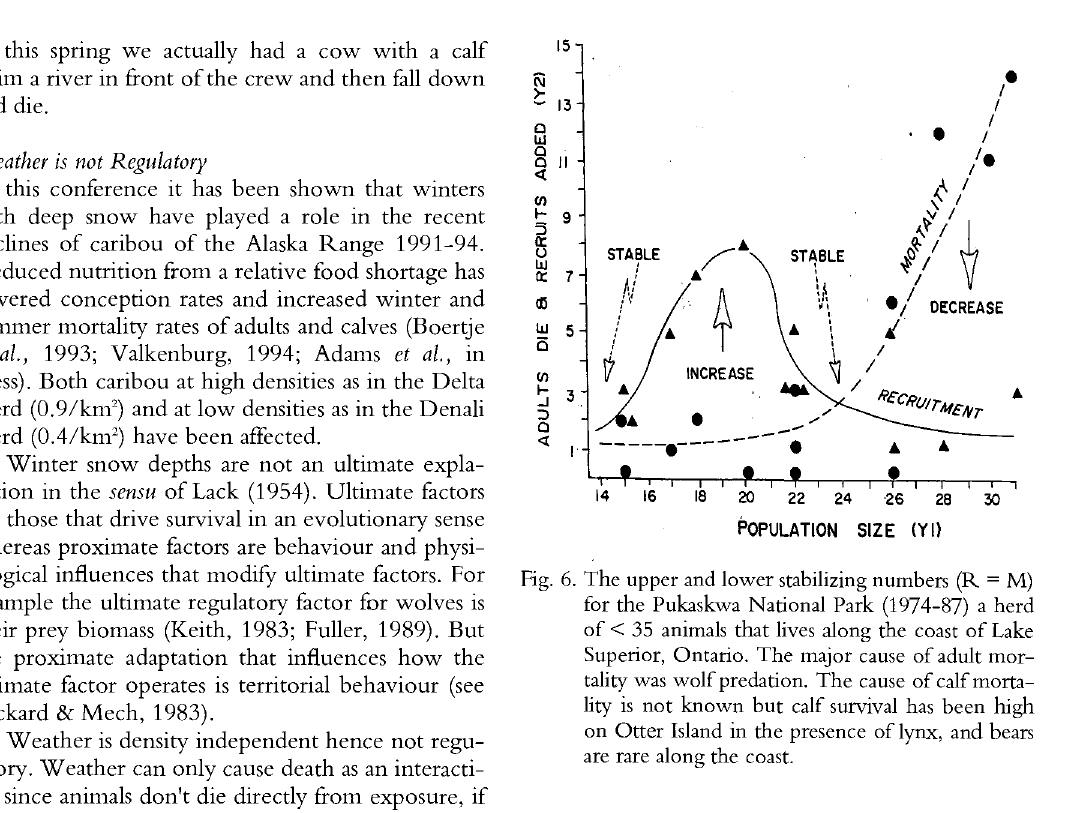
Fig. 6. The upper and lower stabilizing numbers (R = M) for the Pukaskwa National Park (1974-87) a herd of < 35 animals that lives along the coast of Lake Superior, Ontario. The major cause of adult mor tality was wolf predation. The cause of calf morta lity is not known but calf survival has been high on Otter Island in the presence of lynx, and bears are rare along the